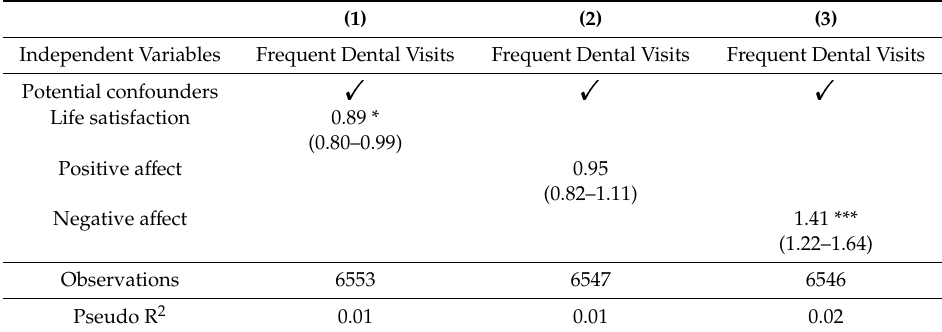
Table 2. Determinants of frequent dental visits (0 = Non-frequent dental visits; 1 = Frequent dental visits; cut-o ff at the highest decile). Results of multiple logistic regressions 1 .